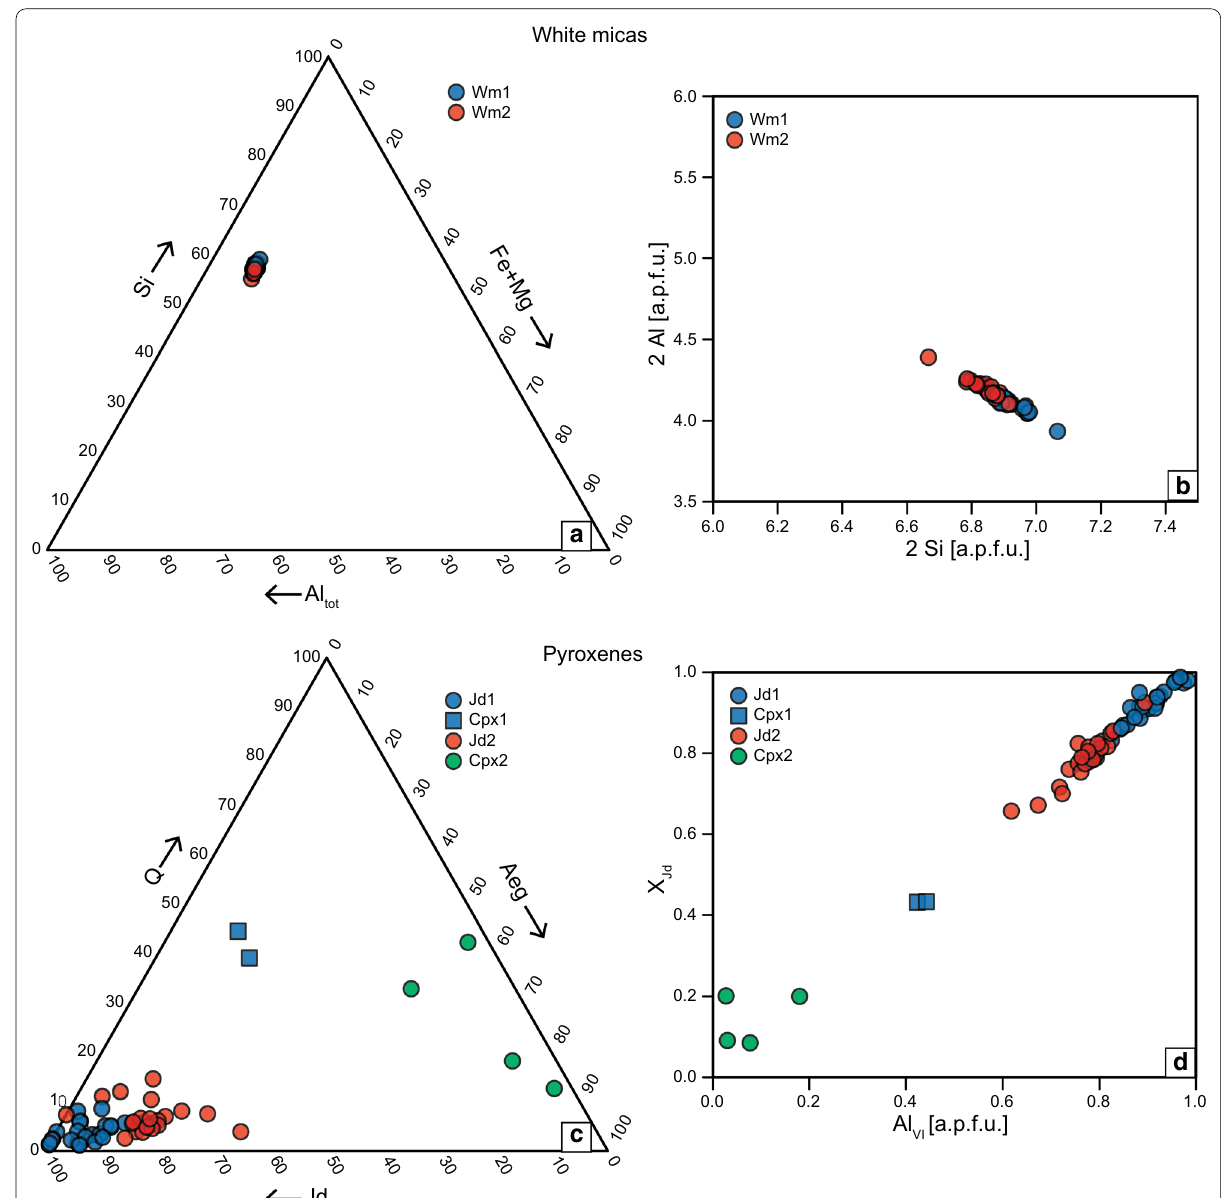
Fig. 9 Compositional variations of Wm ( a , b ) and Px ( c , d ) in garnet-free gneisses (CR115). a , b Wm1 and Wm2 have has phengite composition. c , d X Jd content in Jd1 is > 80% and in Jd2 is between 60 and 80%. Cpx1 is omphacite and Cpx2 has aegirine